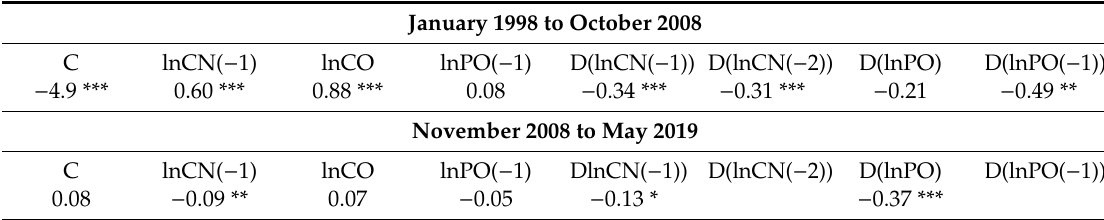
Table 9. ARDL long run form of the subsample.